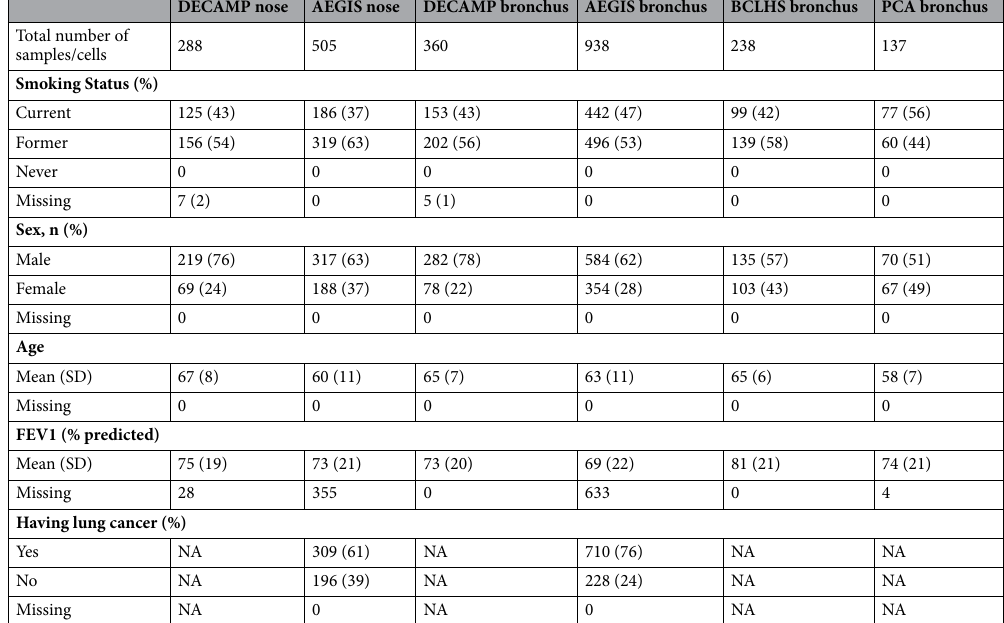
Table 1. Summary of Patient Demographics across Sample Cohorts. Definition of abbreviations: DECAMP : Detection of Early Lung Cancer Among Military Personnel, AEGIS : Airway Epithelial Gene expression in the Diagnosis of Lung Cancer, BCLHS : British Columbia Lung Health Study and Pan-Canadian Lung Health Study, PCA : Pre-Cancer Atlas. Values are presented as mean (standard